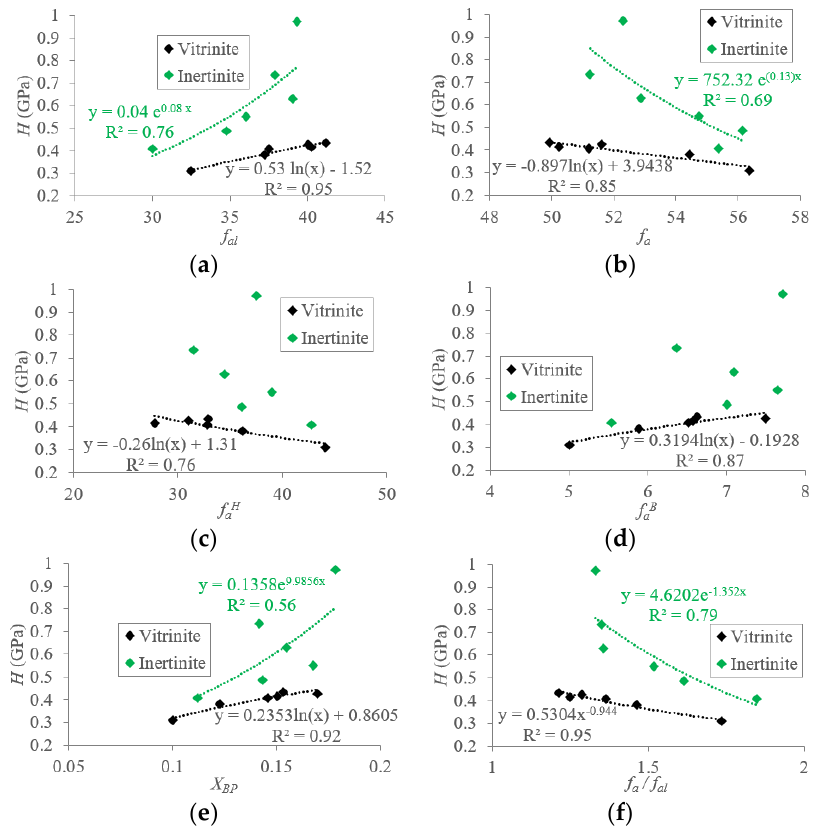
Figure 13. Relationships between NMR parameters (( a – f ) are the f al , f a , f aH , f aB , X BP , and f a /f al , respectively) and H . (Note: Here, H is the mean value for each sample).